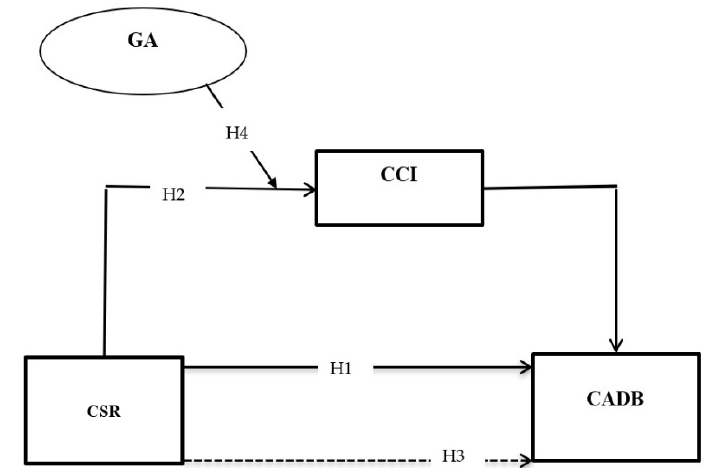
Figure 1. Theoretical framework.